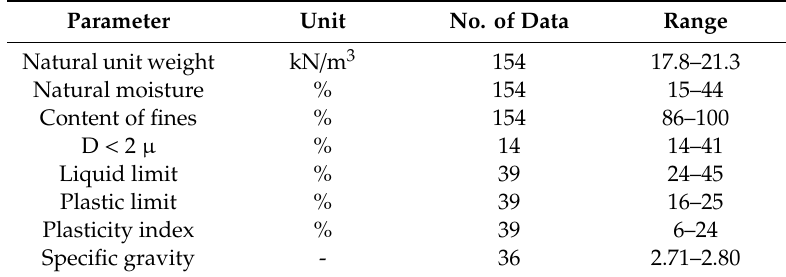
Table 2. Summary of index properties.